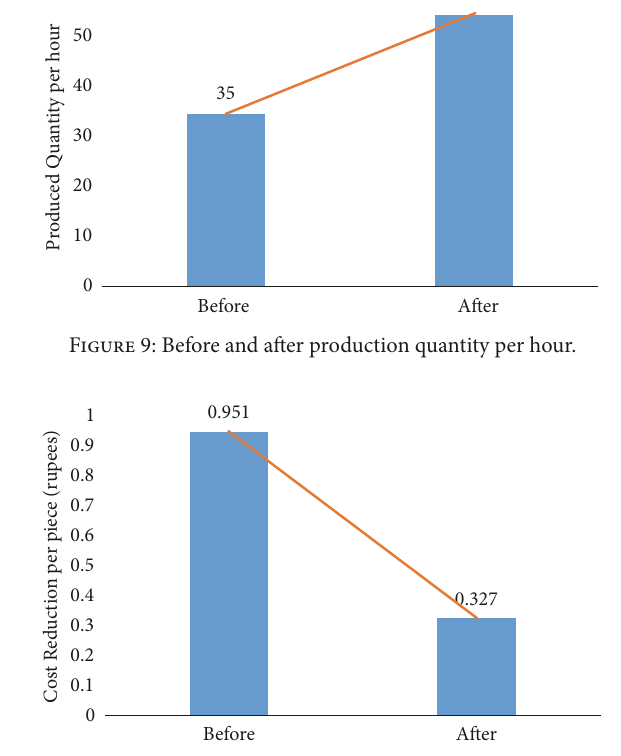
Figure 10: Before and after cost per